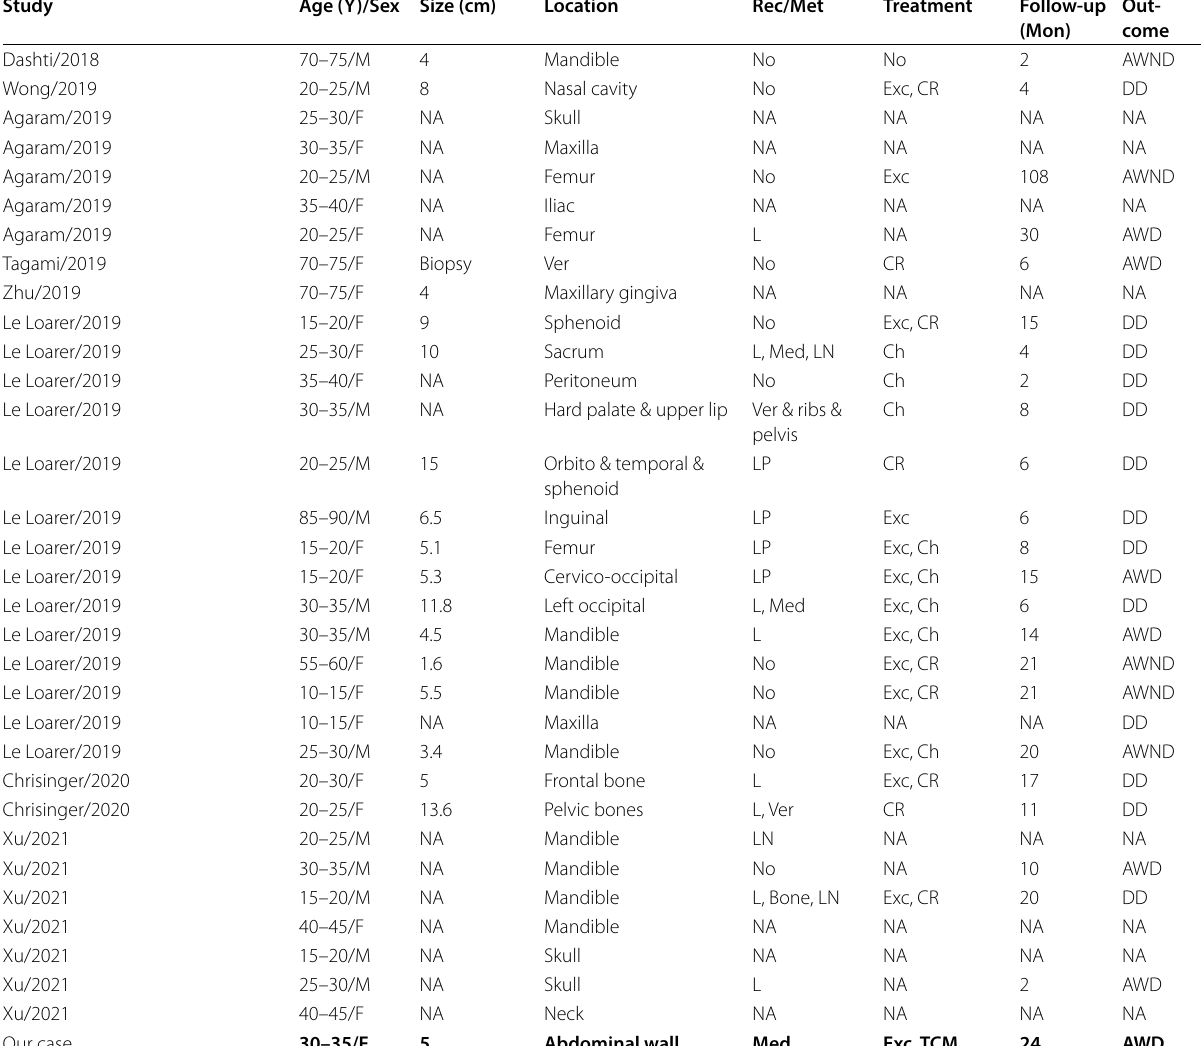
Table 1 Clinicopathological and prognostic characteristics of epithelioid and spindle rhabdomyosarcoma